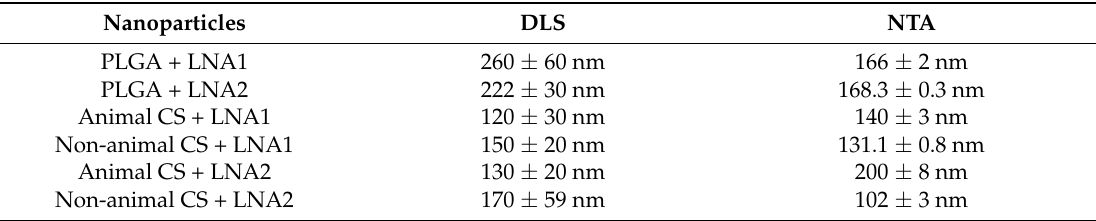
Table 2. Comparison of the measurements performed by Dynamic Light Scattering (DLS) and Nanoparticle Tracking Analysis (NTA) regarding the average size diameter of the Locked-Nucleic Acid Nanoparticles (LNA-NPs).